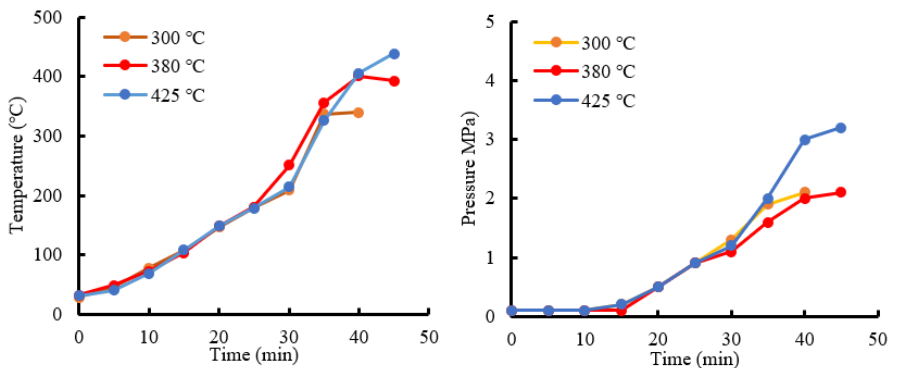
Figure 9. Temperature–pressure changes of group 2